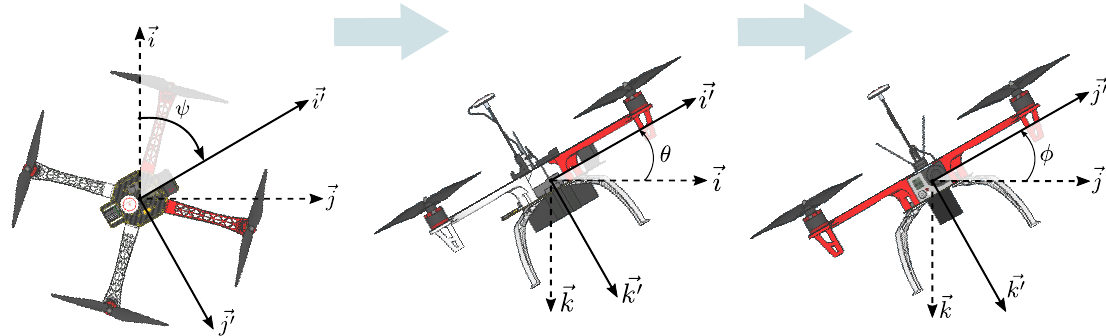
Figure 2. Quadrotor orientation, yaw ( ψ ), pitch ( θ ) and roll ( φ )